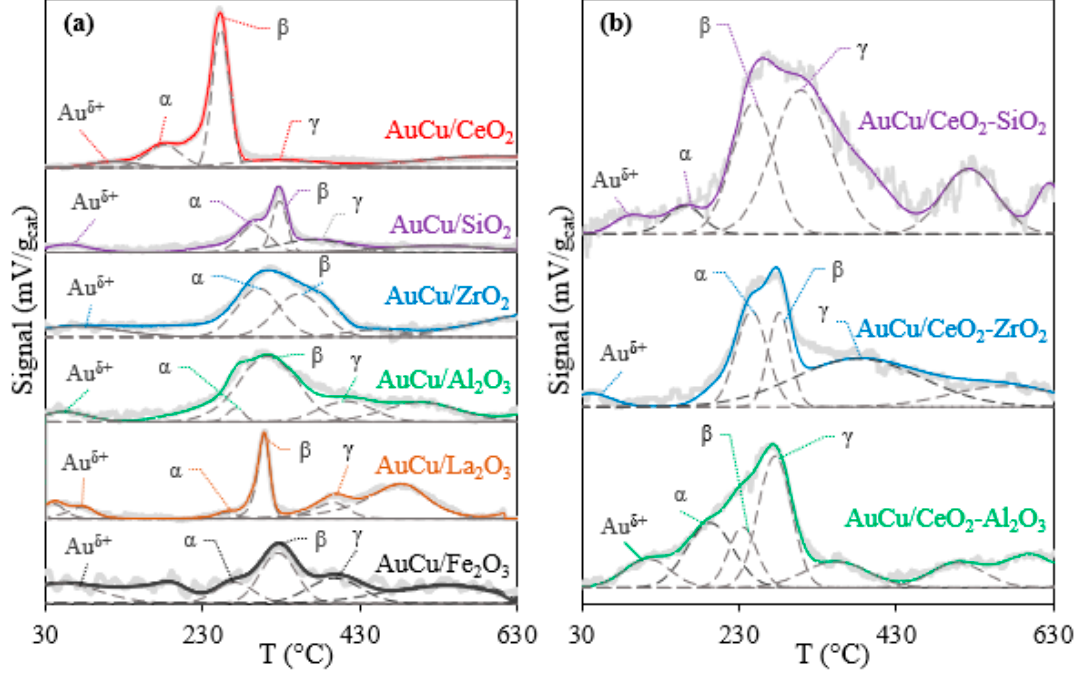
Figure 6. H 2 -temperature programmed reduction (TPR) profiles for Au–Cu catalysts supported on ( a ) single and ( b ) dual metal oxides.